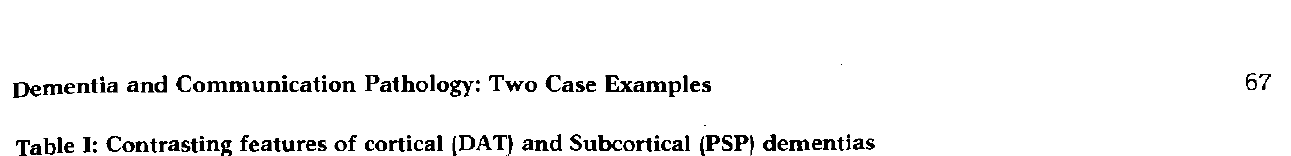
Table I: Contrasting features of cortical (DAT) and Subcortical (PSP) dementias AFTER Albert et al. (1974); Appel et al. (1982); Bayles & Kaszniak (1987); Cummings (1986); Cummings & Benson (1984); Cumm-